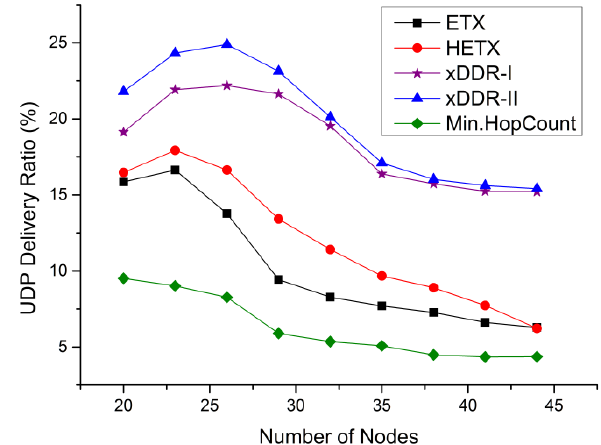
Figure 8: UDP Data Delivery Ratio